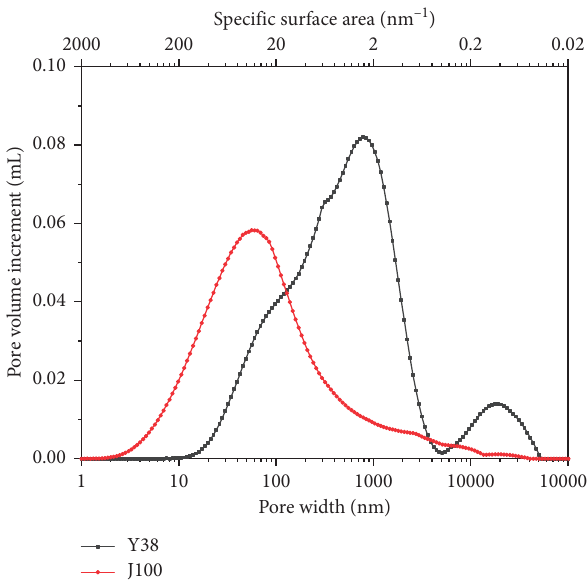
Figure 10: Plots of the specific surface area ( S / V ) distribution of samples Y38 and J100 based on NMR